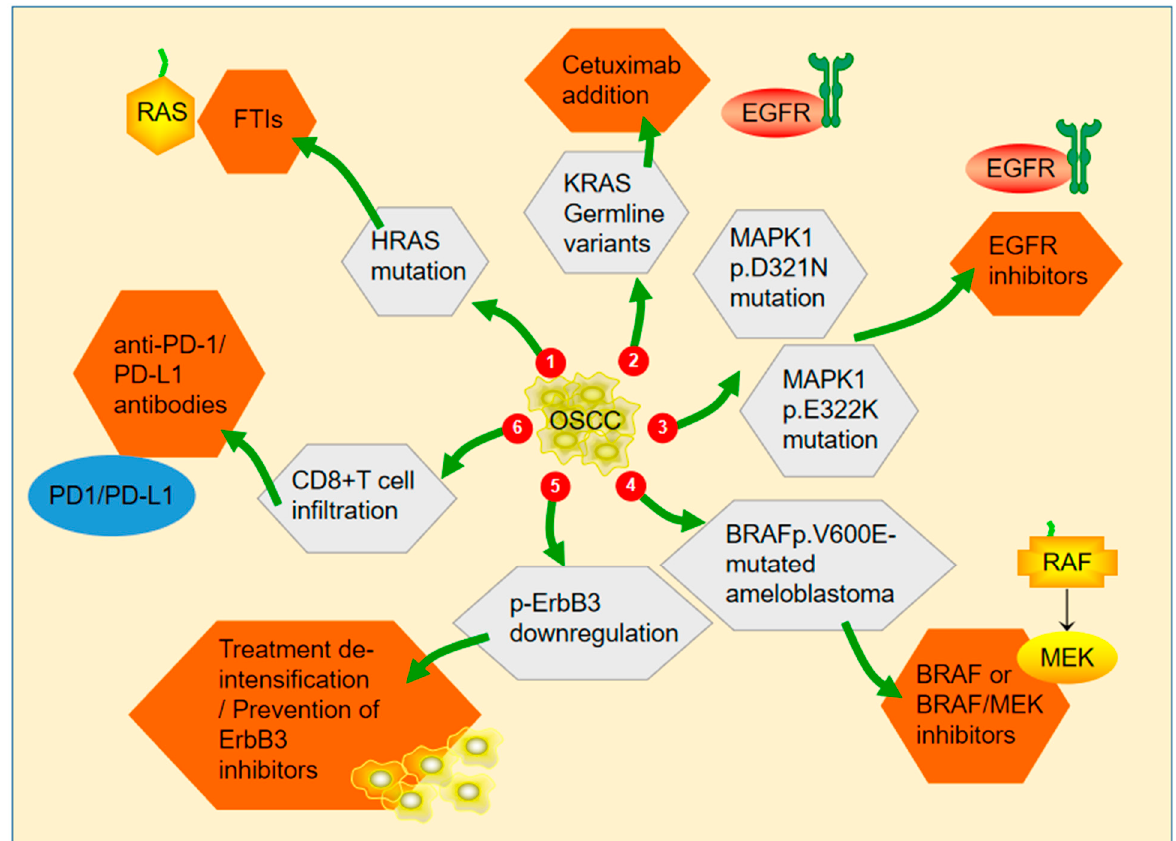
Figure 3. (1) Simultaneous inhibition of ERK and farnesyltransferase inhibits the growth of HRAS- mutated head and neck squamous cell carcinoma, and tipifarnib is currently being rapidly designated by the FDA for the treatment of HNSCC with HRA mutations. (2) Cetuximab is effective for the treatment of KRAS mutant types of HNSCC.(3)MAPK1 mutations can be targeted by EGFR in- hibitors. (4) Glaucocytoma with BRAF p.V600E mutation is more sensitive to BRAF monotherapy or BRAF/MEK combination therapy. (5) Combined blockade of EGFR and ERBB3 promoted rapid tumor regression. (6) CD8+ T cell infiltration in MAPK mutant HNSCC may be an indicator of anti- PD-1 /PD-L1 inhibitor therapy.